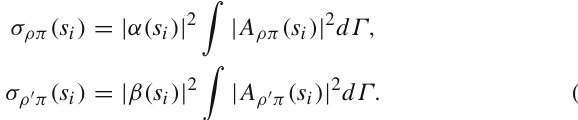
Fig. 6 The x 1 distribution and M π + π − spectrum for two energy √ s = 1 . 42–1.48 MeV intervals: √ s = 1 . 65–1.68 MeV. The and points with error bars represent data. The solid histogram is the result of the fit described in the text. The dashed, dash-dotted, and hatched histograms show the distributions corresponding to the squared amplitudes for the intermediate states ρ( 770 )π , ρ( 1450 )π and ωπ 0 , respectively. The dotted histograms in the right plots show the total contributions of the ρ( 770 )π and ρ( 1450 )π intermediate states including the interference term